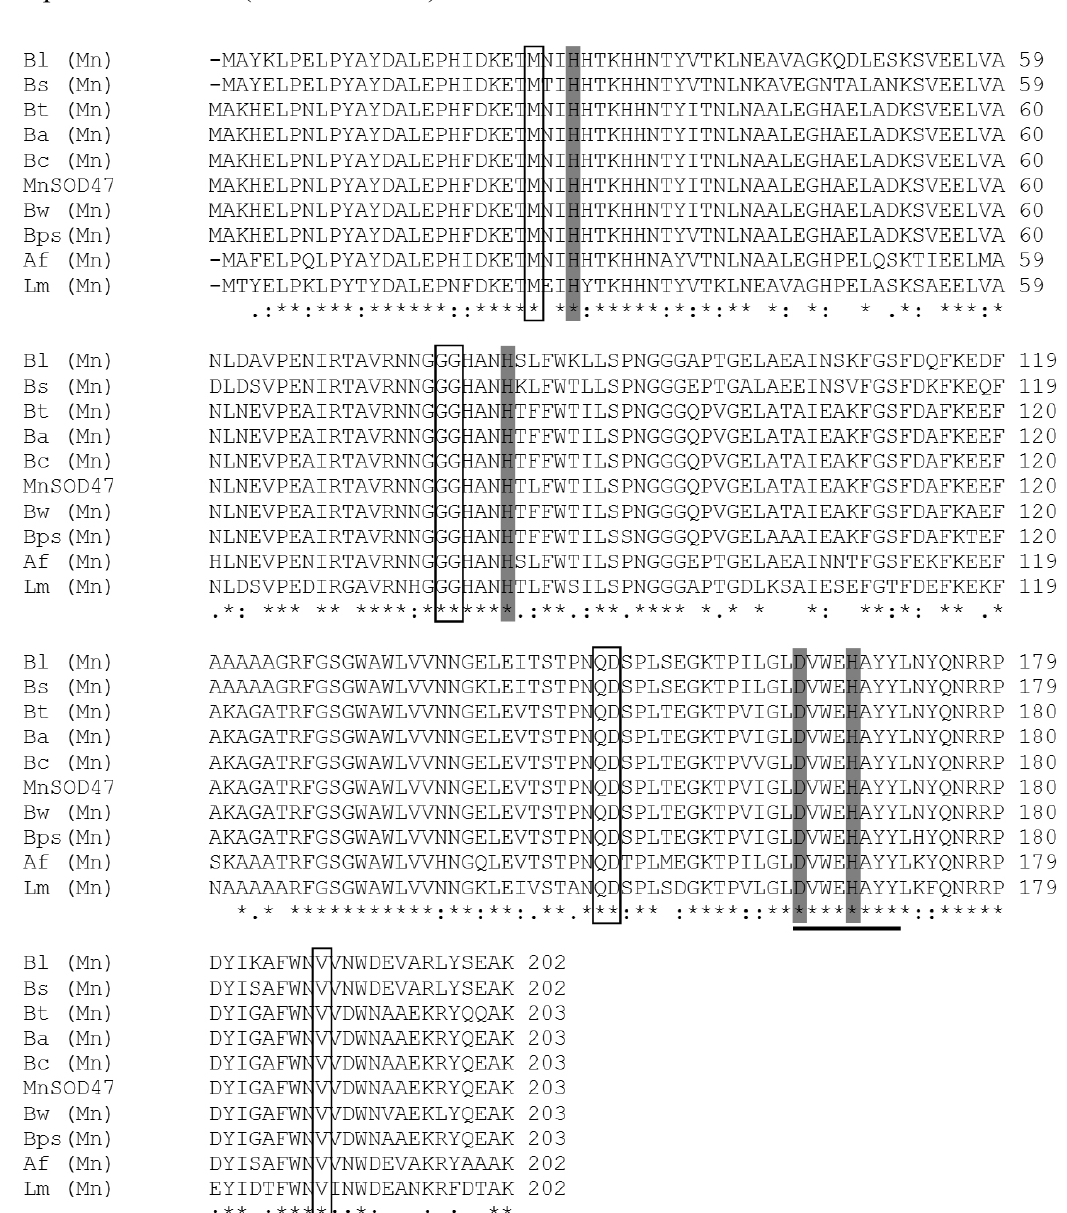
Figure 2. Alignment of the amino acid sequence of MnSOD47 with those of other bacterial MnSODs: B. licheniformis (Bl, accession no. YP_079829); B. subtilis (Bs, accession no.